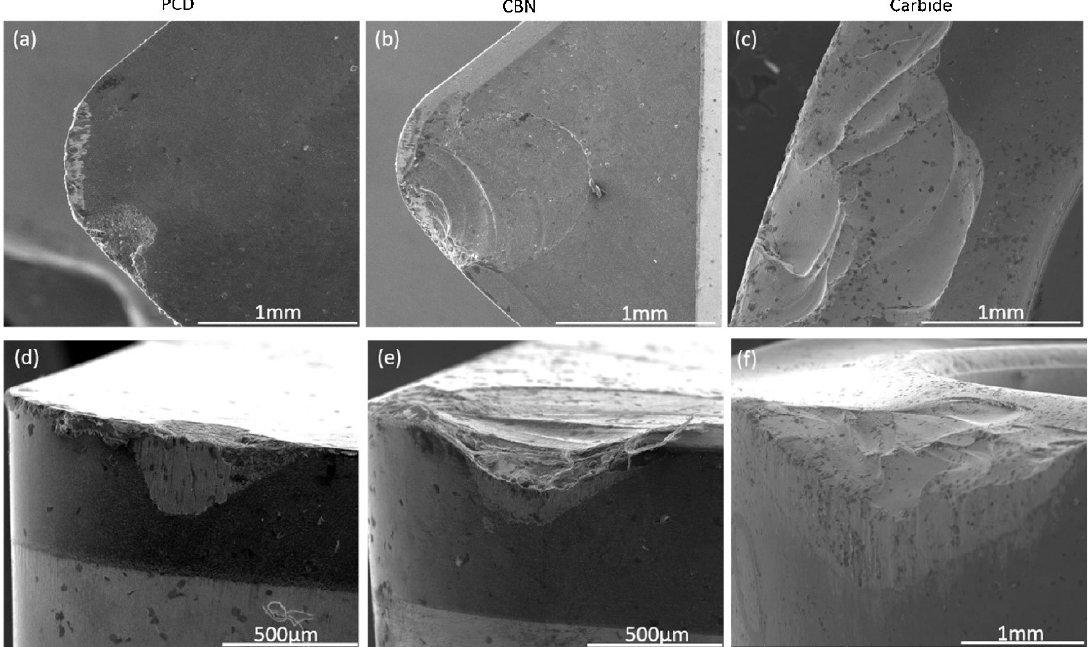
Figure 16. ( a ) Rake face of PCD tool; ( b ) rake face of CBN tool; ( c ) rake face of coated carbide tool; ( d ) flank face of PCD insert; ( e ) flank face of CBN insert; and ( f ) flank face of coated carbide tool [131] (Reprinted with permission from [131]. Copyright 2018, Elsevier).